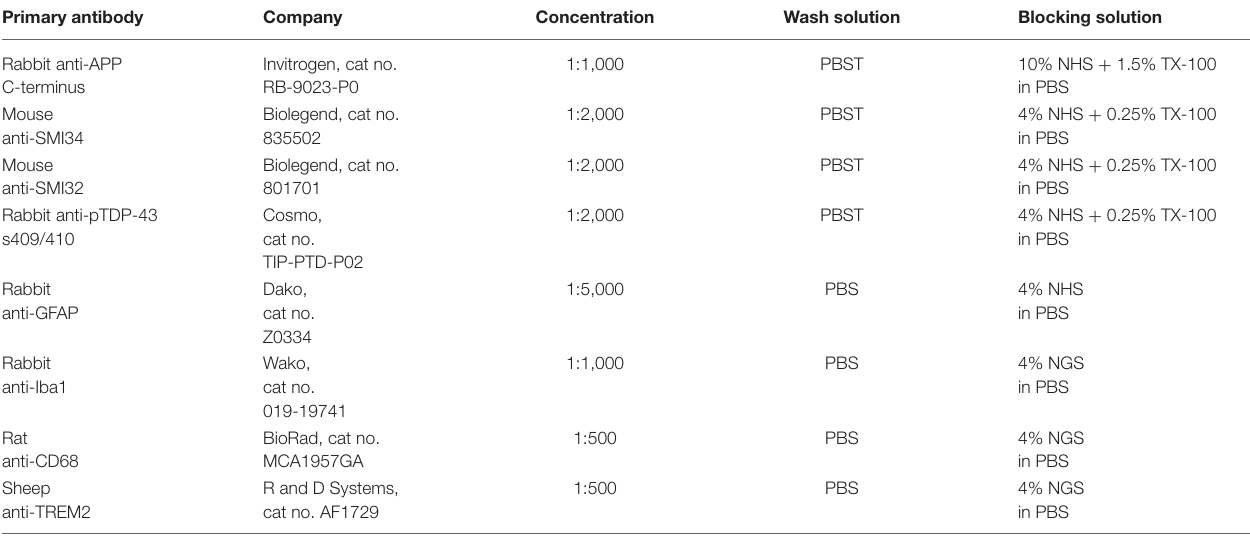
TABLE 1 | Antibody and blocking solution information used when conducting nickel-enhanced 3,3-diaminobenzidine (DAB) and fluorescent-labeling immunohistochemistry. Primary antibody Company